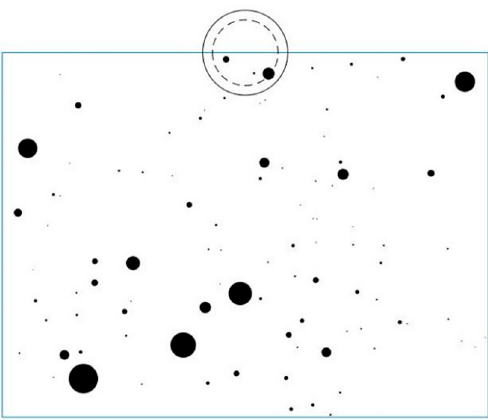
Figure 2. An example of a tunnel partially located outside the rectangular control area to simulate different geologic units being present in a tunnel section.